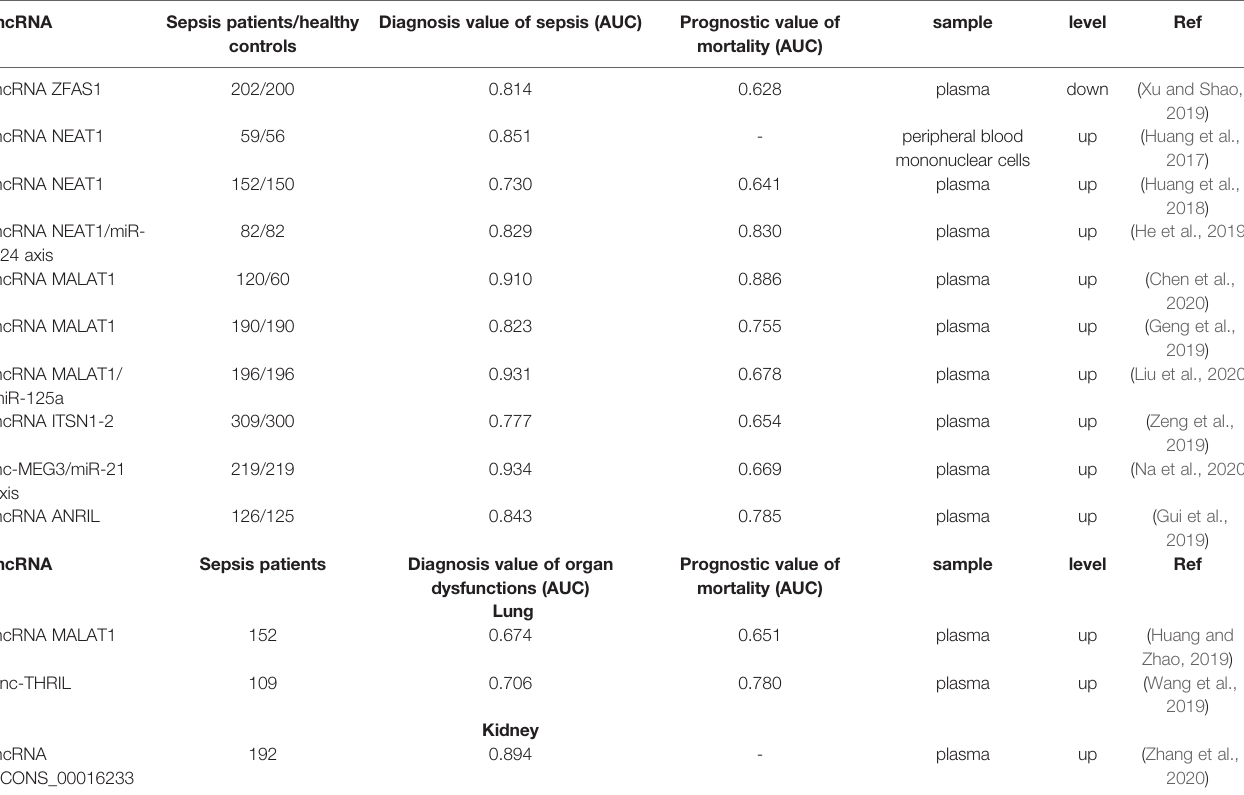
TABLE 1 | lncRNAs as potential biomarker for sepsis and sepsis-induced organ dysfunctions. lncRNA Sepsis patients/healthy controls